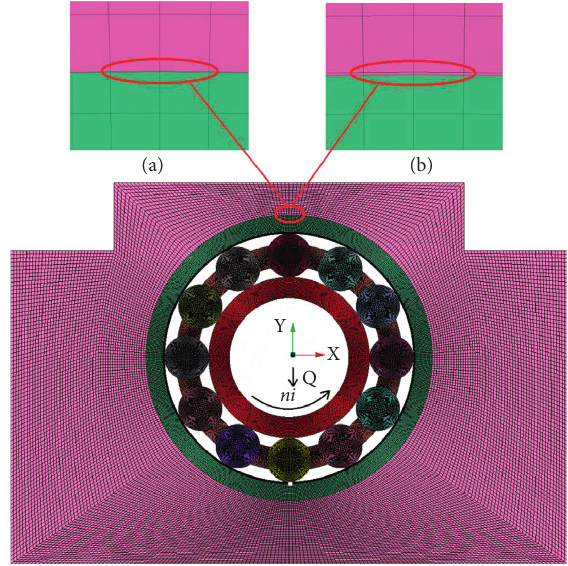
Figure 2: Two-dimensional finite element model of the bearing housing system: (a) common node model and (b) contact pair